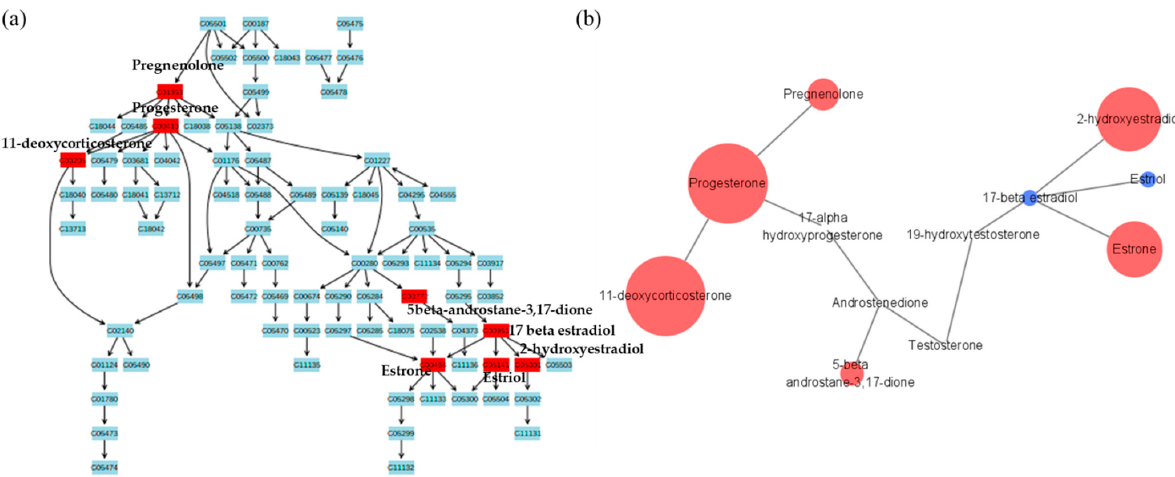
Figure 6. Metabolites with differences between female groups in steroid metabolic pathway. ( a ) Metabolites in red indicate significant differences between groups and ( b ) the pathway mapping of metabolites and relative quantitation between female pattern baldness patients and female controls. The larger the circle, the larger the relative quantitative value. Red circles indicate higher metabolite concentration in the patient group and blue circles indicate higher metabolite concentration in the control group.